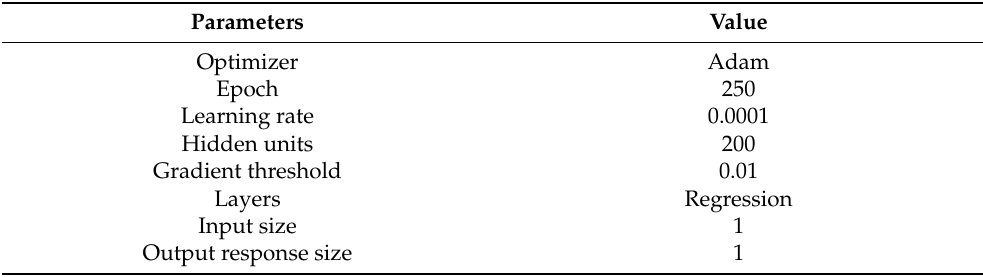
Table 2. Training hyper-parameters for LSTM.